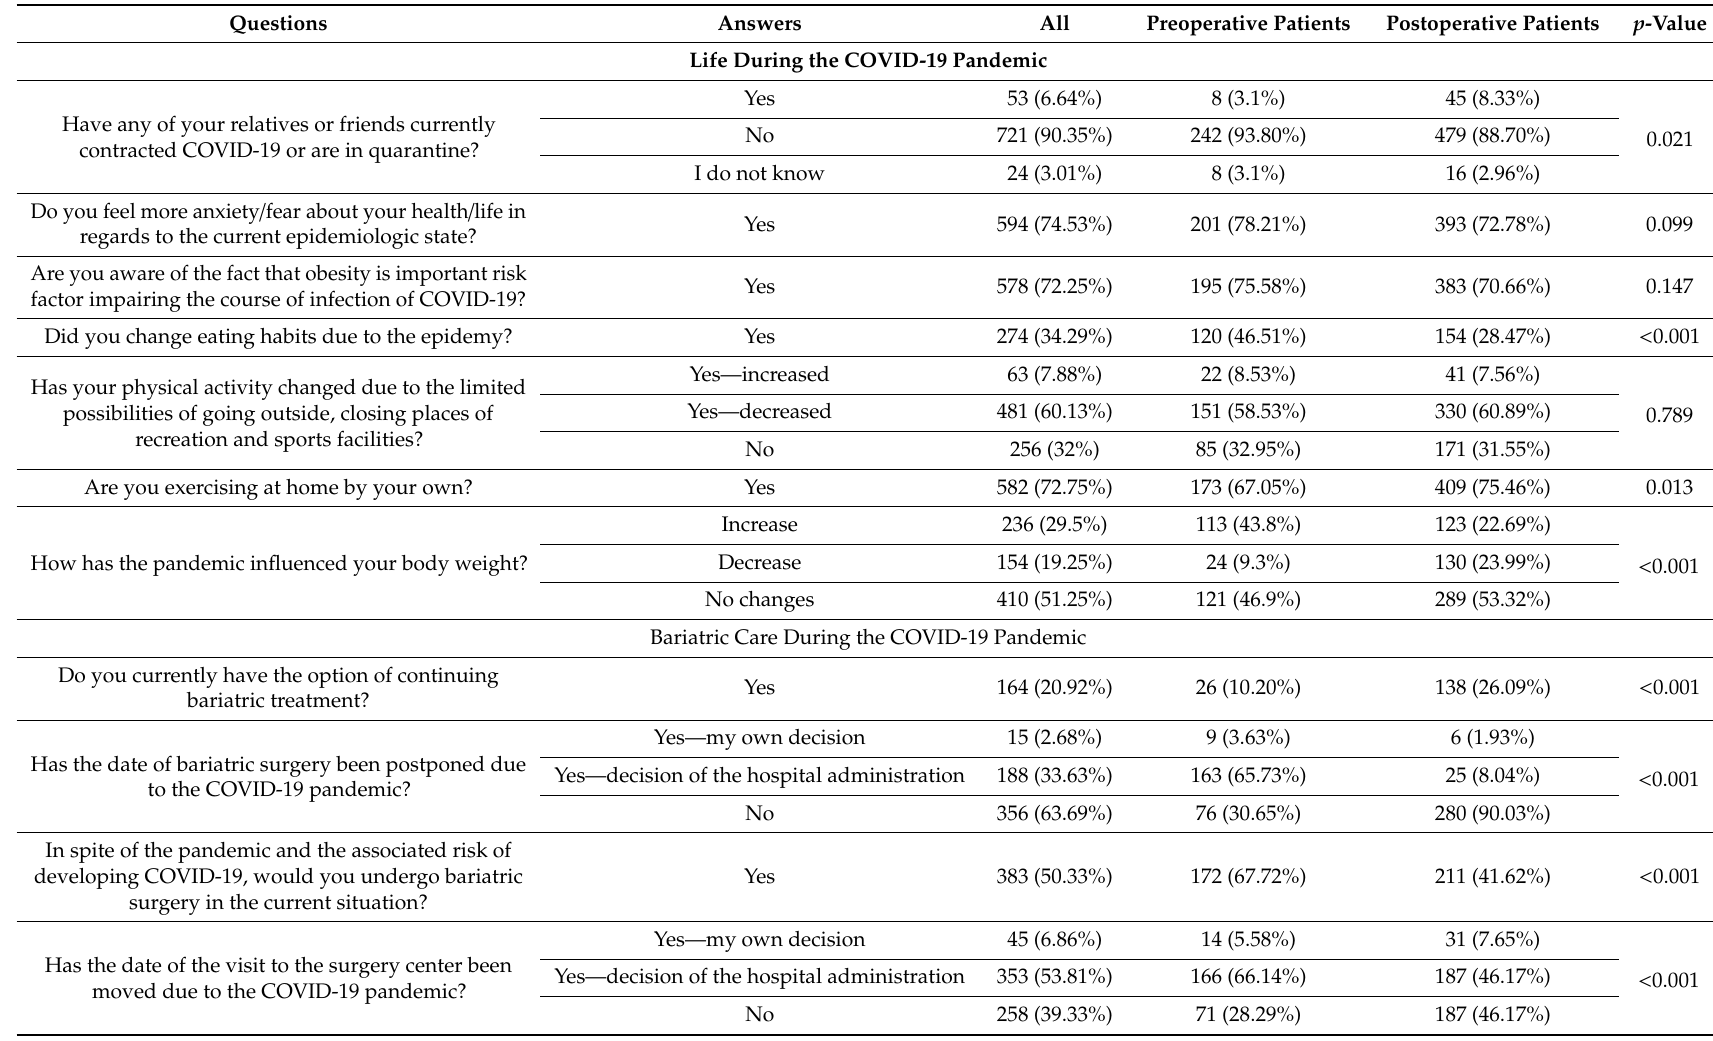
Table 2. Results of the